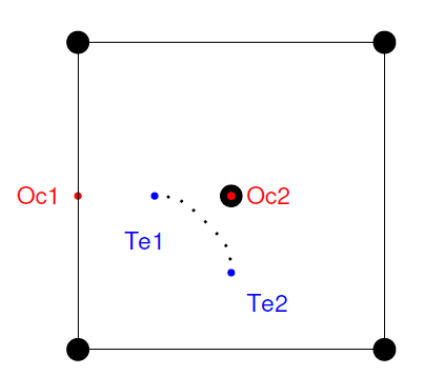
Figure 7. Relaxed migration path of an oxygen atom between two tetrahedral sites on a ( 001 ) plane under zero strain showing two neighboring octahedral sites for reference. The trajectory follows a curved path arched towards the closest octahedral